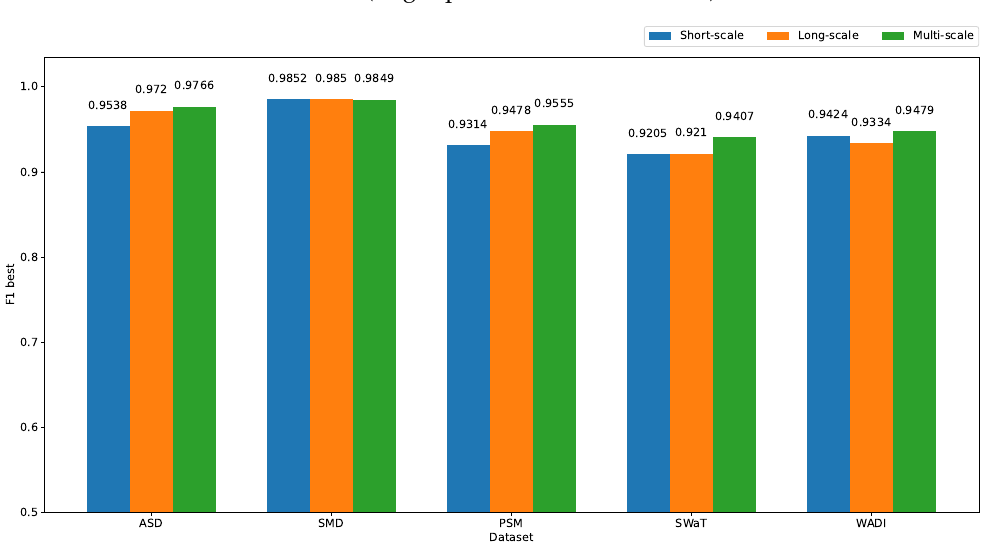
Figure 8. Performance comparison between short-scale, long-scale, and multi-scale